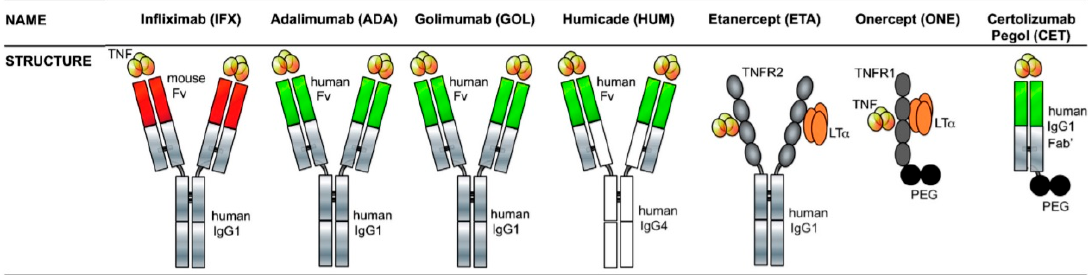
Figure 1. Mucosal immunology of the gastrointestinal tract (GIT) under homeostasis, acute inflammation and chronic inflammation in inflammatory bowel diseases (IBD). The aberrant immunological response of the innate immune system induces an acute inflammatory state that may progress to chronic inflammation with a prominent role of the adaptive immune system. The involved cytokine network is complex and shows a major role of the proinflammatory cytokine tumor necrosis factor- α (TNF- α ). For an explanation and overview of all the abbreviations, the reader is referred to the original work of this Figure [4]. Reprinted from Friedrich et al. [4] with permission from Elsevier.